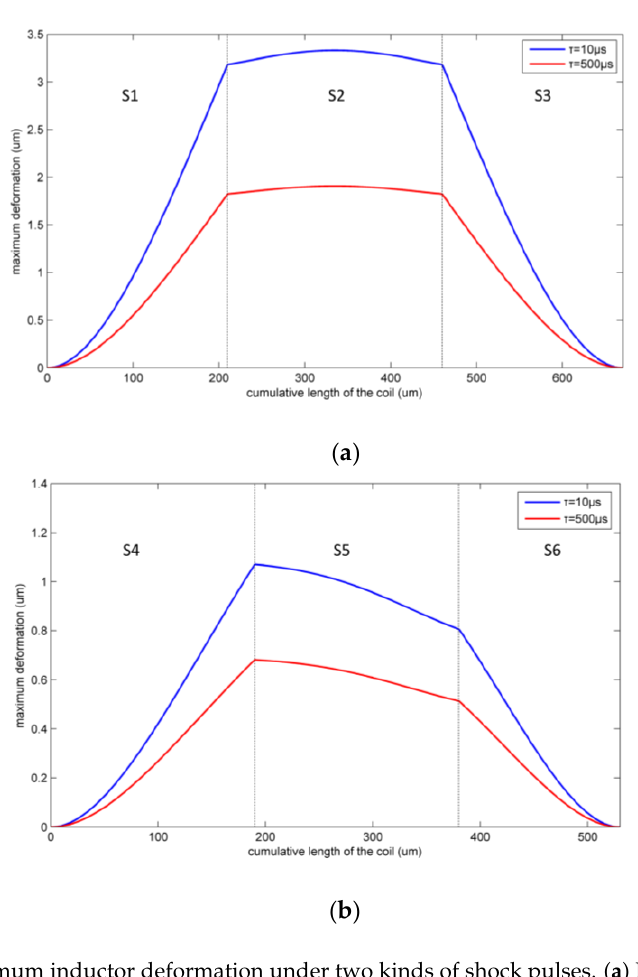
Figure 11. Maximum inductor deformation under two kinds of shock pulses. ( a ) Part 1; ( b ) Part 2. By varying the shock amplitude from 0 g to 35,000 g, a series of maximum deformations of the